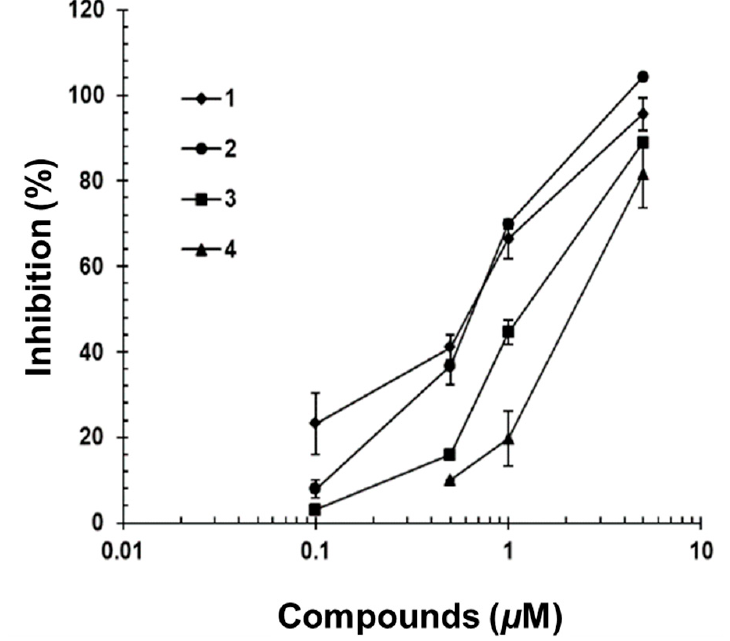
Figure 4. Inhibitory effects of 1 – 4 on IL-6/STAT3 transcriptional activity in Hep3B cells. The pSTAT3-inducible luciferase activity was measured by luciferase assay. Three independent